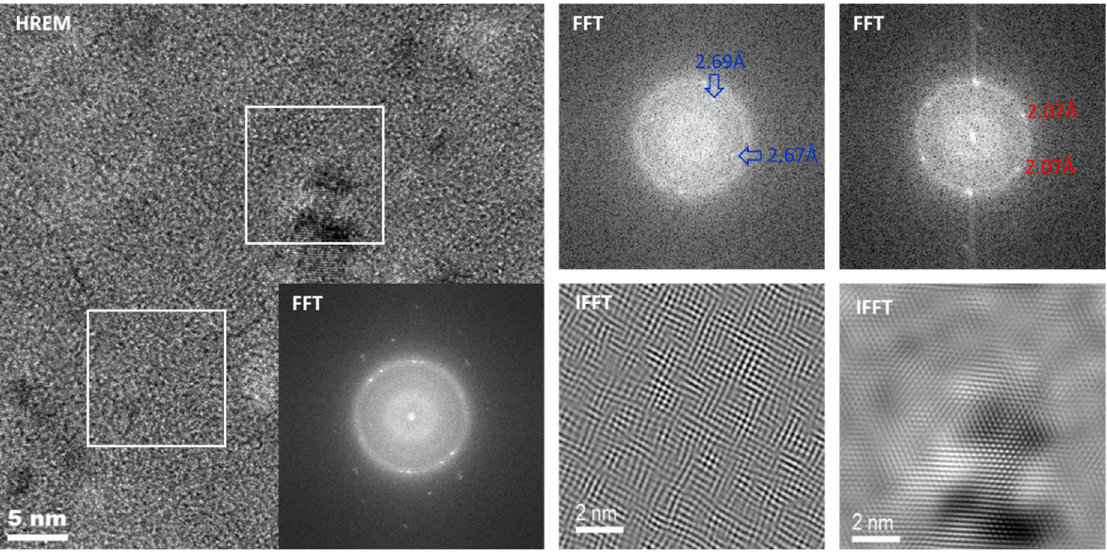
Figure 9. HRTEM, FFT, and IFFT images of Fe 70.4 Ni 8 Nb 4 Cu 1.6 Si 2 B 14 annealed at 560 °C.